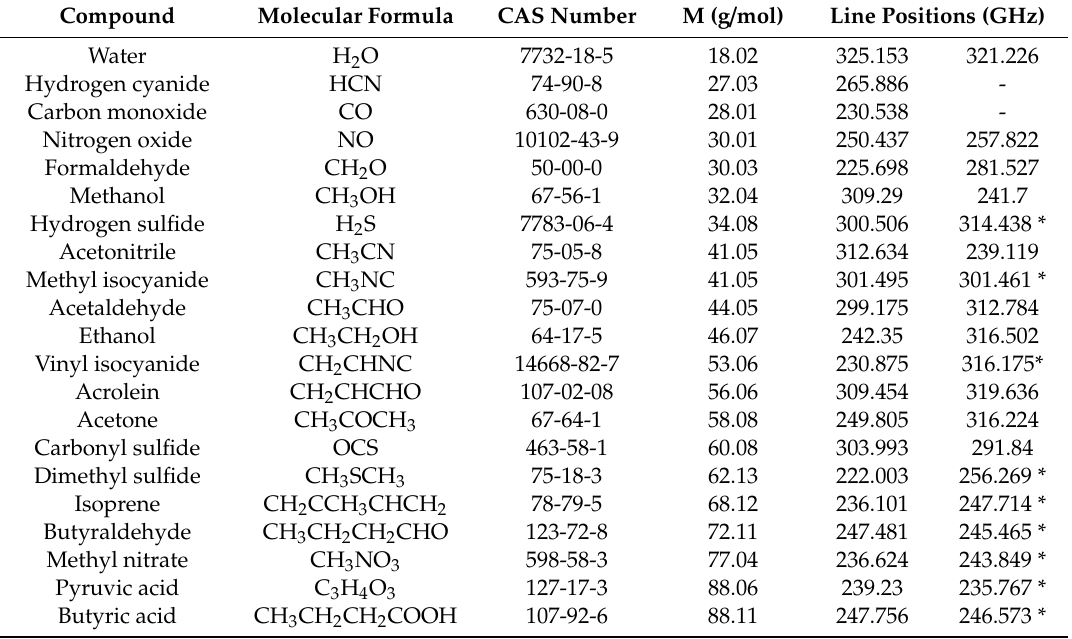
Table 1. Detected molecular species and corresponding scanned absorption lines sorted by the molecular masses M. The lines were chosen by strength and isolation from other known lines. The line positions were taken from [24] (M < 61) and [38] (M > 61). Lines marked with a star (*) were searched for but not detected in the spectra. Hydrogen cyanide and carbon monoxide have only one line in the spectral range of the